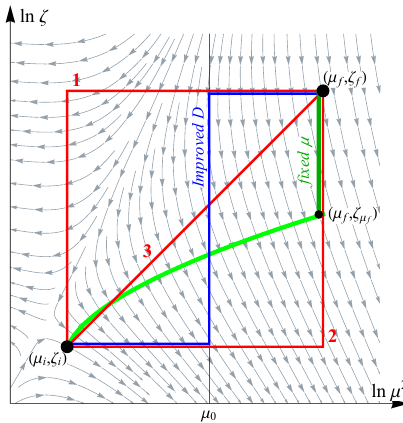
Figure 1 . Illustration of evolution paths corresponding to di(cid:11)erent solutions. Red lines show the solutions 1, 2, and 3, de(cid:12)ned in eqs. (2.14), (2.15), and (2.14), correspondingly. The blue line shows the path of the improved D solution (4.6) with the normalization point (cid:22) 0 . Green line shows the path of the (cid:12)xed- (cid:22) solution, (2.35). The light-green curve shows the null-evolution curve